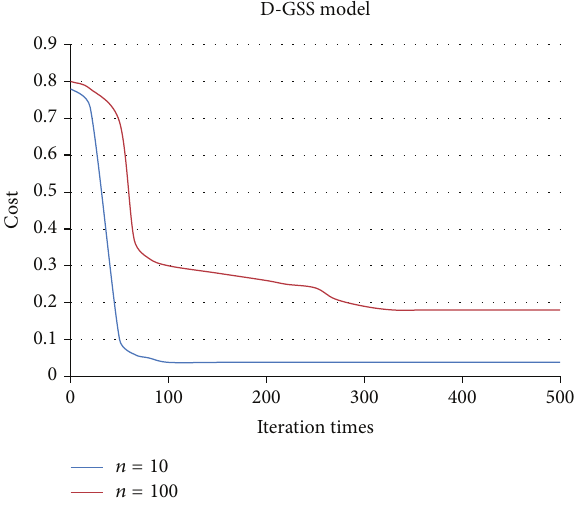
Figure 2: Convergence for 𝑛 = 10, 100